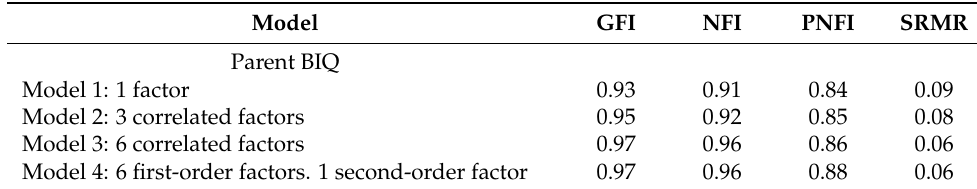
Table 3. Fit Indexes for each Model for parents, mother and father reports of Behavioral Inhibition Questionnaire